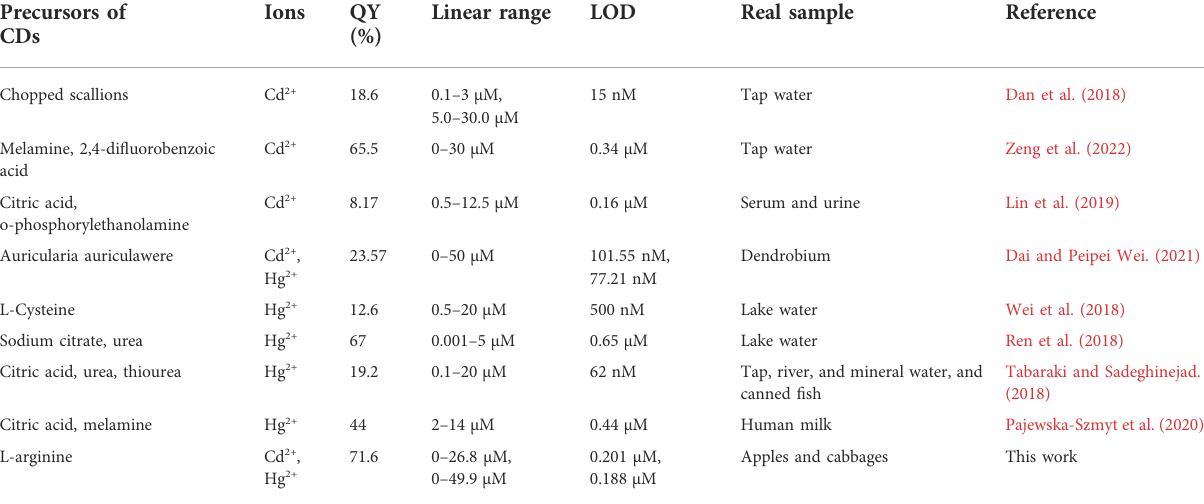
TABLE 2 Comparison of different methods for the detection of Cd 2+ and Hg 2+ using CDs as sensing probes. Precursors of